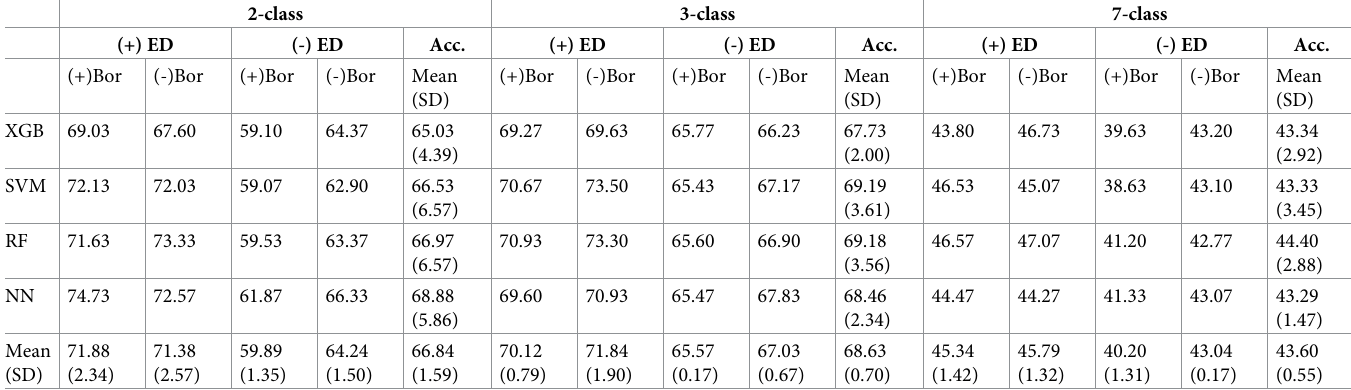
Table 3. The classification accuracy rate by recalibrated dataset (with and without environment data) in each